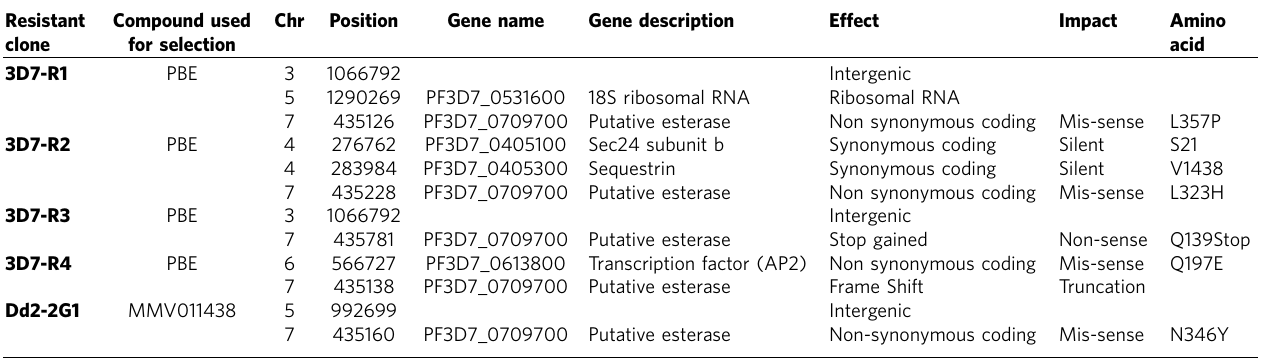
Table 2 | Whole genome sequencing of PBE and MMV011438 resistant parasite clones. Resistant Compound used clone for